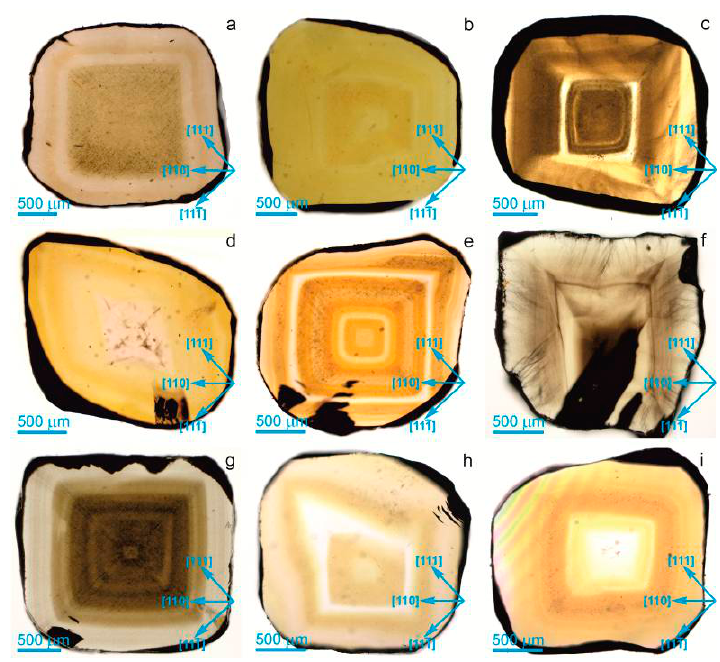
Figure 3. Internal structure of yellow cuboid diamonds from the Northeastern Siberian platform (optical microphotographs of double-polished plates parallel to (110), transmitted polarized light) ( a —The crystal MP-30 having zonal structure, cube-shaped core with microinclusions located by chains that defined radial distribution; b —The diamond MP-43 having cubic zones of slightly different intensities of yellow coloration; c —The crystal MP-56 with zonal distribution of numerous microinclusions, there are inclusion-free zones and zones with different densities of microinclusions; d —The crystal MP-60 having light yellow inner core and intense yellow outer zones; e —The diamond MP-71 having numerous cubic zones with different intensity of yellow coloration; f —The diamond MP-83 with clear zonal and sectorial texture; there are radial chains of microinclusions in outer zones; g —The crystal MP-87 having zonal structure having muddy yellow core zone with high microinclusion density and an inclusion-free rim. In core there are several zones with different inclusions density; h —The diamond having distorted cubic zones with different intensities of yellow colour; i —The diamond having colourless inner core and numerous cubic zones with different intensity of yellow colour in outer rim).